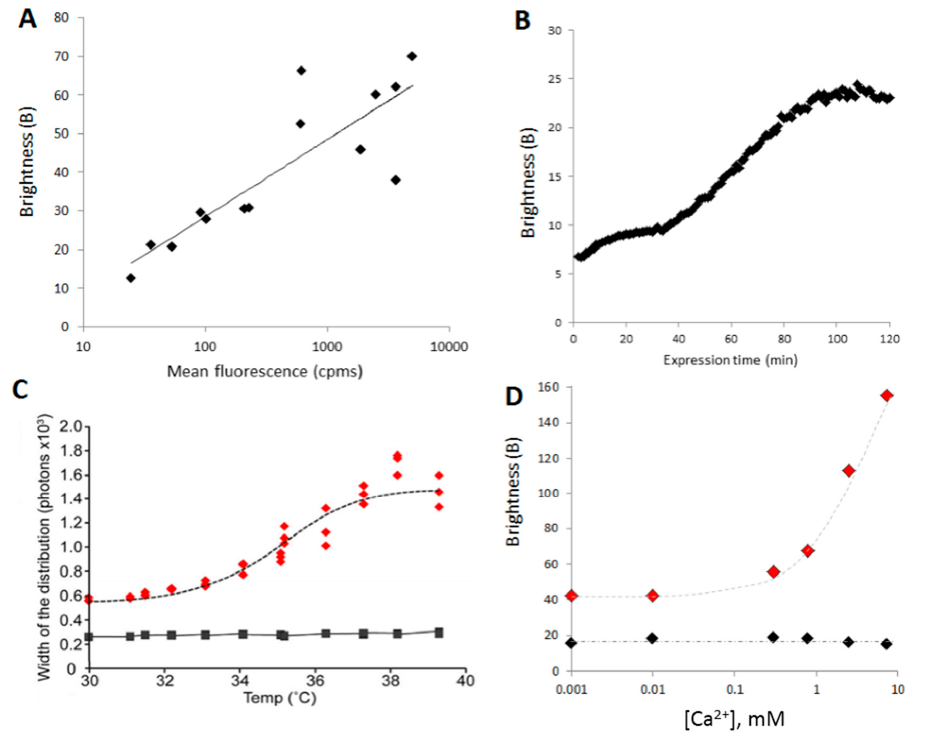
Figure 8. B is a useful parameter in screening assays: ( A ) B as a function of the final concentration of protein. α -Synuclein A30P/A53T, tagged with sGFP at its C-terminus, was expressed at different final concentrations by using a range of dilutions of the template DNA. All expressions were diluted 10 times and 100 s time traces were acquired; ( B ) Variation of B during the expression of the protein. The expression of GFP-foldon was started directly under the microscope by adding the template DNA to the cell-free lysate in the sample holder. Sixty-second time traces were acquired every minute for 2 h; ( C ) B can be used to follow the thermal denaturation of a protein. Here, Munc18-1 WT (black) and mutant (C180Y, red) were expressed as GFP fusion proteins for 2 h and then treated at different temperatures for 1 h. Three time traces of 30 s were acquired for each temperature treatment; ( D ) Changes in aggregation behavior upon calcium treatment. α -synuclein WT (black) and mutant (H50Q, red), tagged with sGFP at the C-terminus, were expressed for 2 h then incubated with different concentrations of Ca 2+ for 1 h. Three time traces of 30 s were acquired for data point.